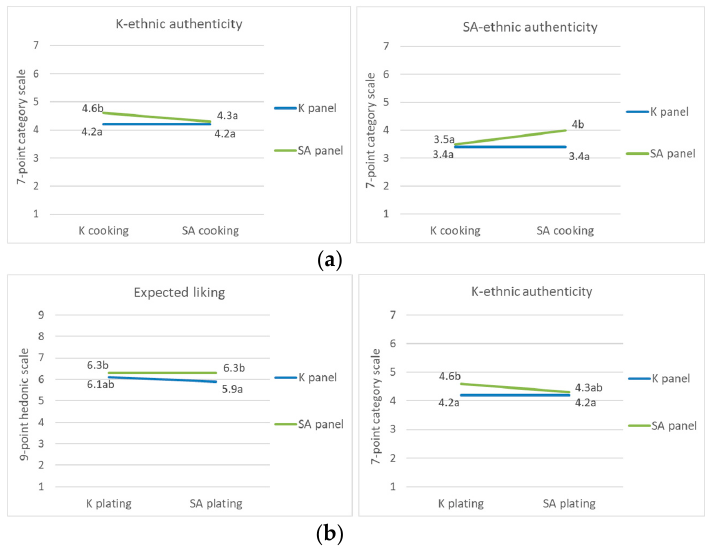
Figure 2. Effect of the ( a ) nationality × cooking process on K and SA ethnic authenticity and ( b ) nationality × plating on the expected liking and K ethnic authenticity, di ff erent letters indicate significant di ff